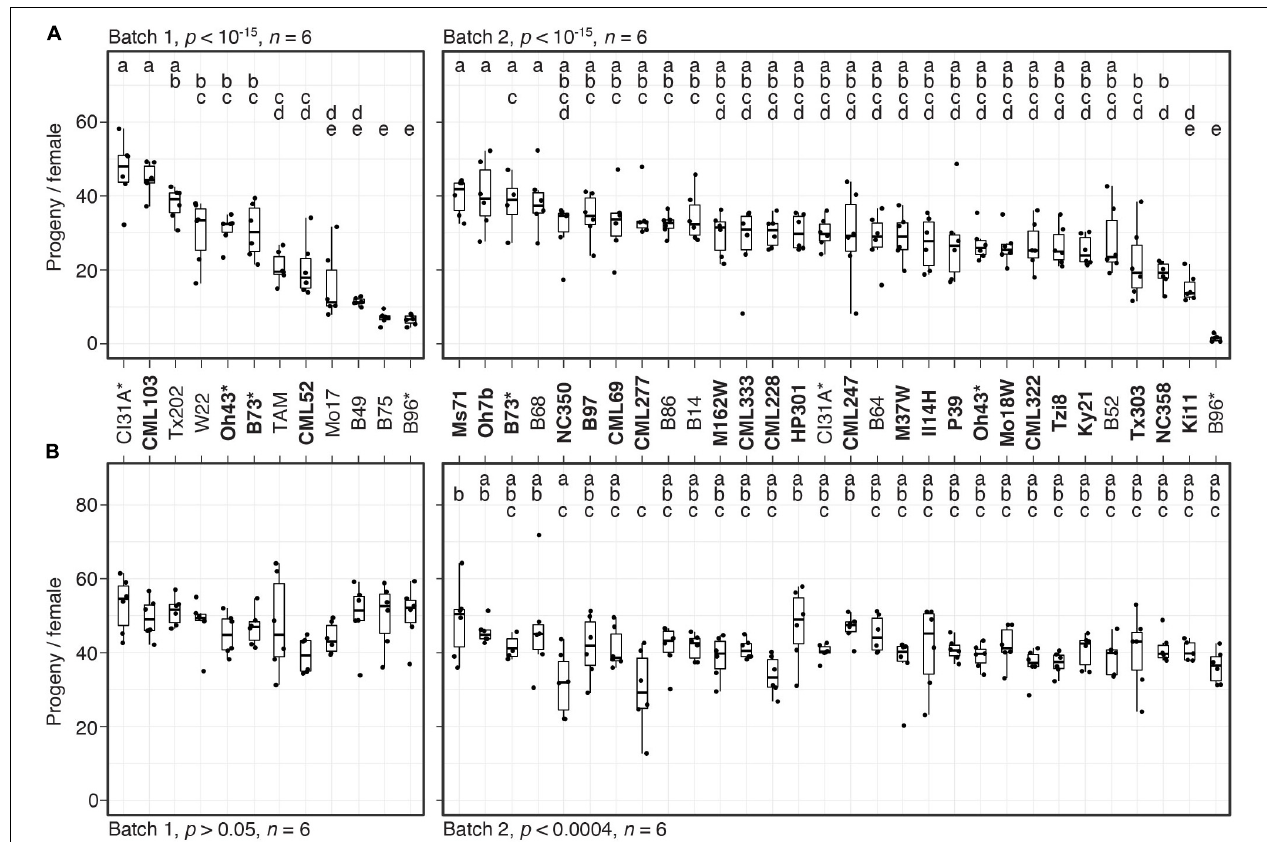
FIGURE 1 | Variation in resistance among 38 maize inbred lines to T. urticae and O. pratensis . Indicated is the number of progeny per adult T. urticae female (A) and O. pratensis female (B) by maize line after 6 days of feeding in enclosures on the 8th leaves (boxplots with overlay of data points are shown). The screen was performed in two batches, 1 and 2 (left and right in each panel, respectively). In (A) , maize lines are ranked by median resistance – least to most, left to right – within each batch; to facilitate comparisons between mite species, the same ranking is used in (B) . Where significant ANOVA results ( p < 0.05) were obtained by batch, pairwise significance was assessed with correction for multiple testing using the Hochberg method (different letters denote significant differences at p < 0.05). Maize line founders of the NAM population are in bold, and four lines included in both batches are indicated by asterisks. Sample size, n (enclosures per maize line, see section “Materials and Methods”), are as indicated except for maize lines B73 (A,B) , B52 (B) , or Ki11 (B) in batch 2, where either four or five enclosures were successfully established. TAM,